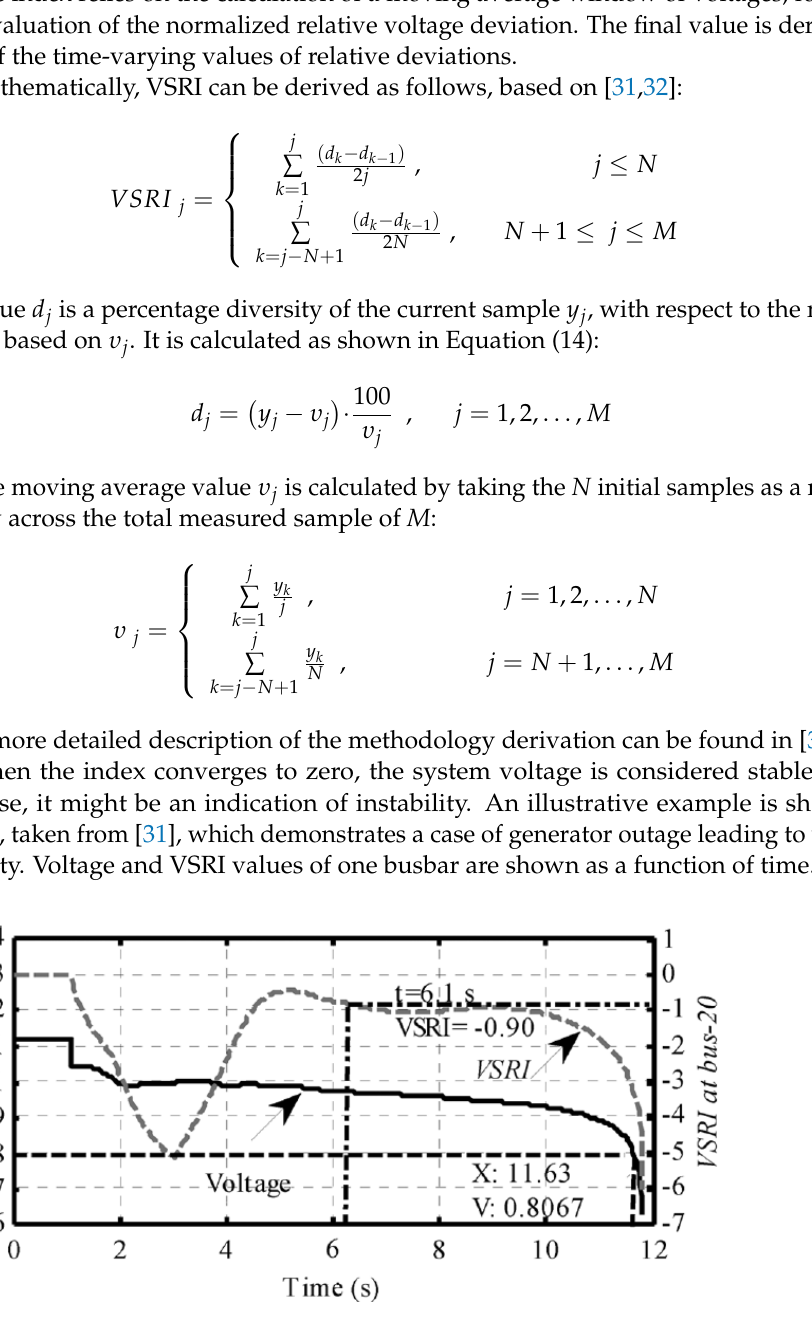
Figure 6. Application of VSRI in detecting voltage instability scenario as a result of a large generator outage [31]. Copyright: IEEE. outage [31]. Copyright permission from